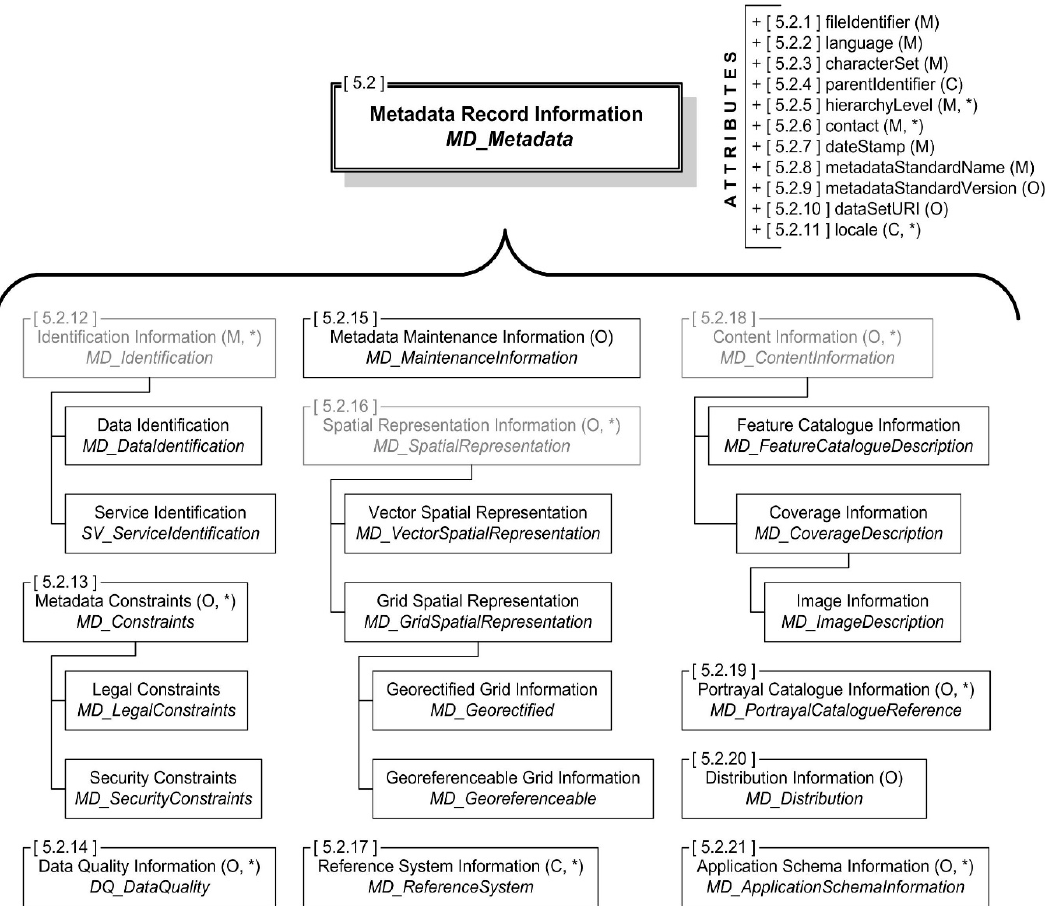
Figure 10. North American Profile ( NAP)-Metadata high level metadata content.